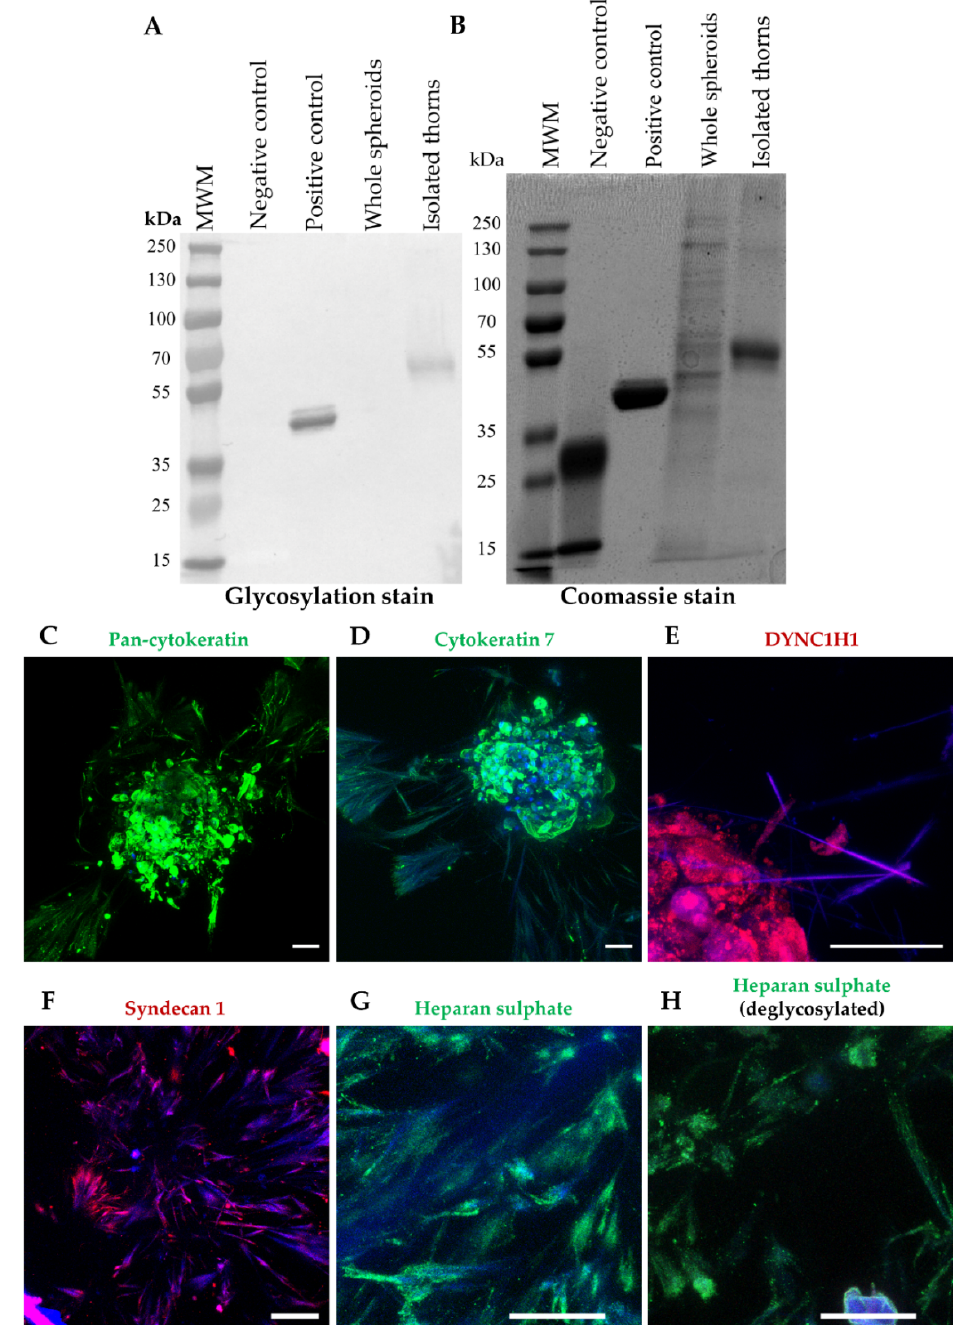
Figure 2. Thorn composition. Glycosylation and Coomassie staining of thorns isolated from donor 1 PHH spheroids treated with 50 µ M GW64712 for 72 h. ( A ) Glycosylation stain. ( B ) Coomassie stain. Immunofluorescence staining of thorns on donor 1 spheroids. ( C ) pan-CK with deglycosylation, ( D ) CK 7, ( E ) cytoplasmic dynein heavy chain 1, ( F ) syndecan 1, ( G ) heparan sulphate without deglycosylation, ( H ) heparan sulphate with deglycosylation. Scale bars are 50 µ